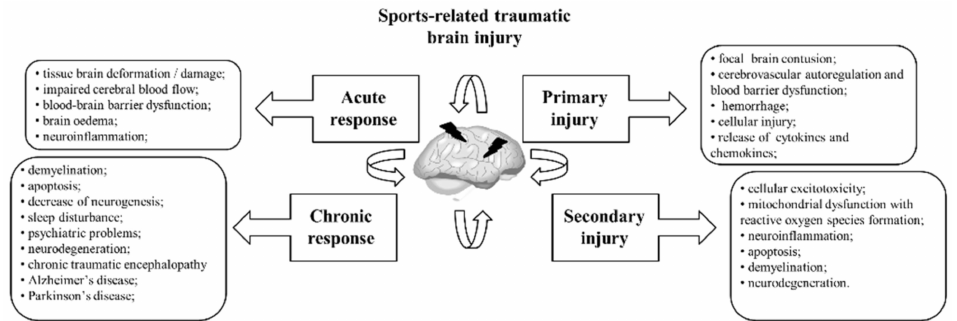
Figure 3. Molecular characteristic of distinct phases of sports-related traumatic brain injuries (primary and secondary) with short- (acute) and long-term (chronic)